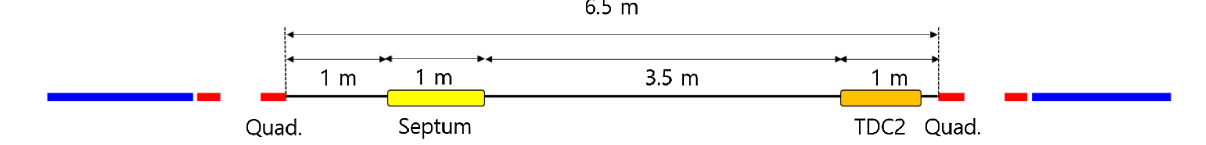
FIG. 5. Layout of the injection element. TDC1 is located in the straight section upstream of the injection region. Blue and red indicate the bending magnet and the quadrupole magnet, respectively.